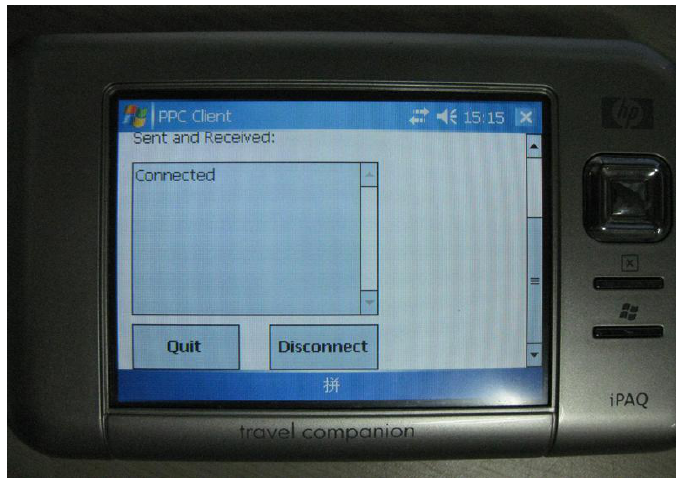
Figure 11. The UI shows that PDA has connected to server.